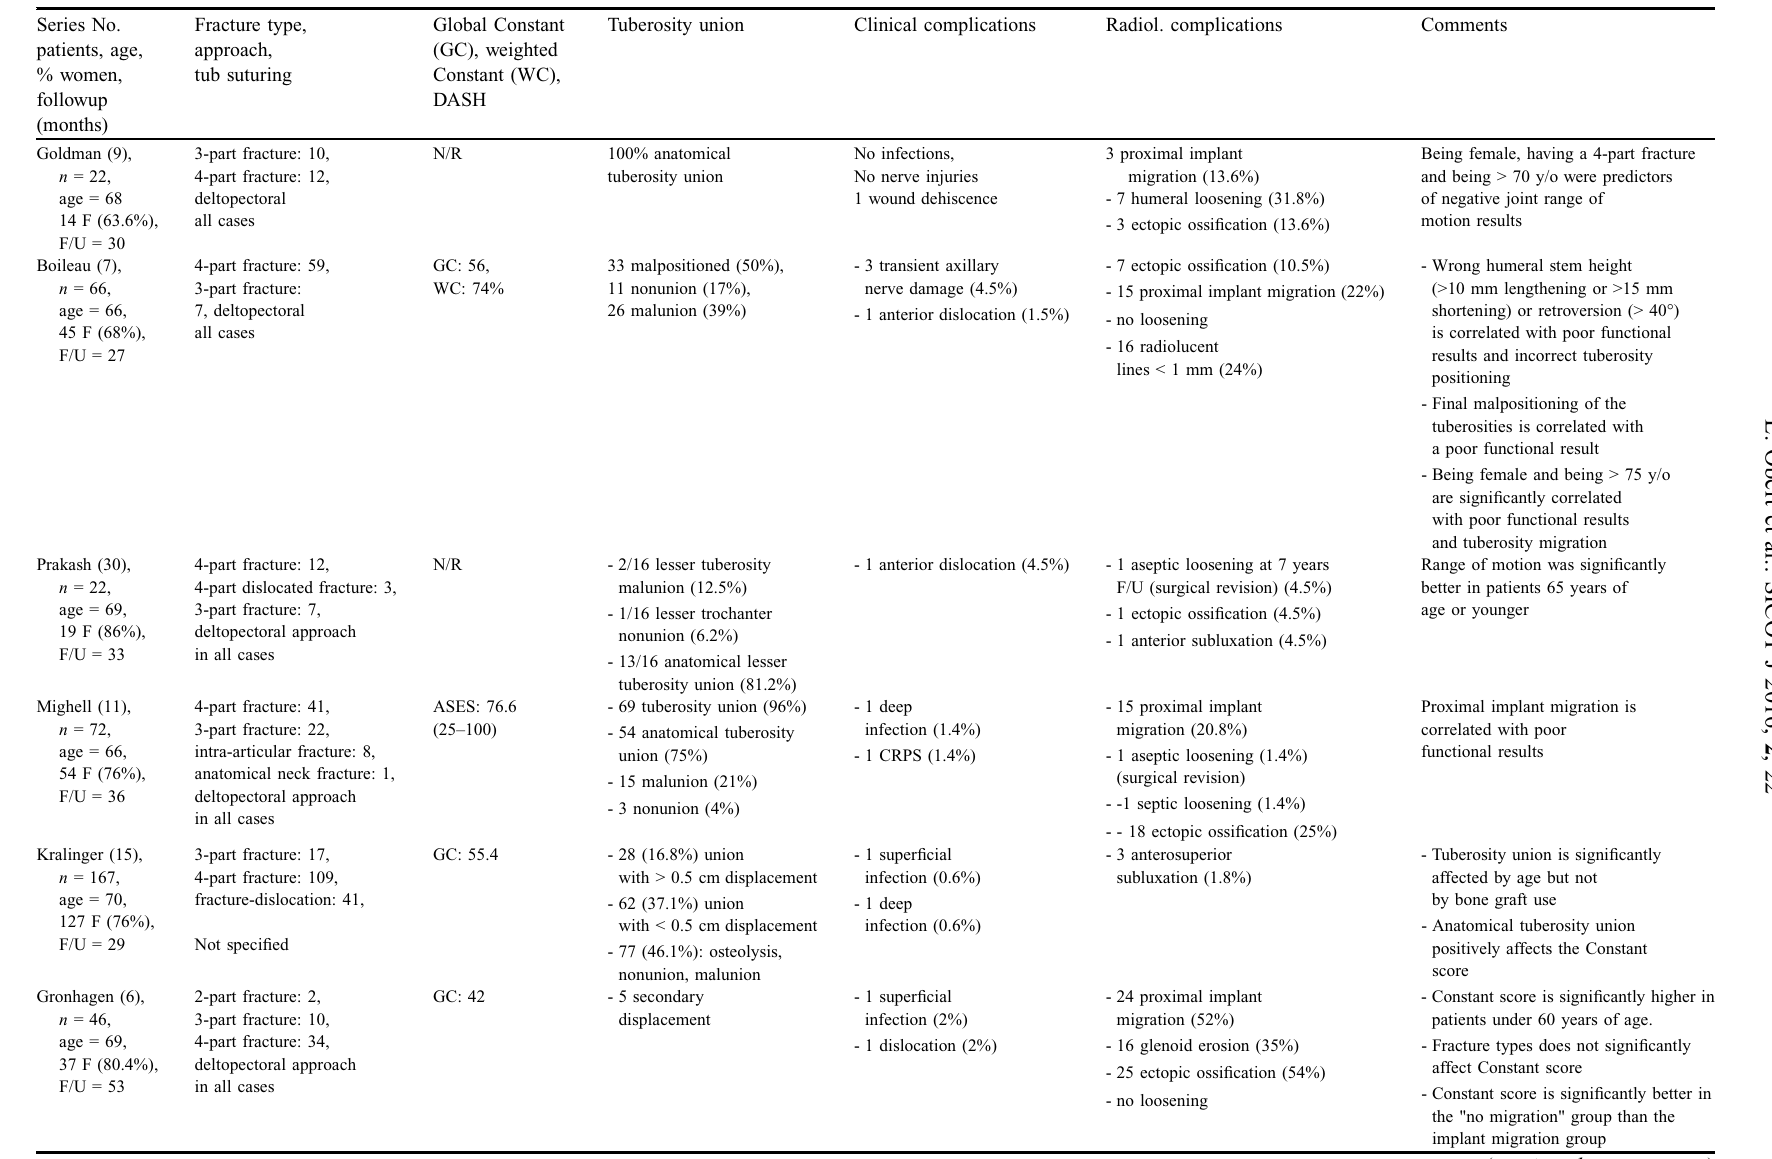
Table 1. Hemiarthroplasty review of